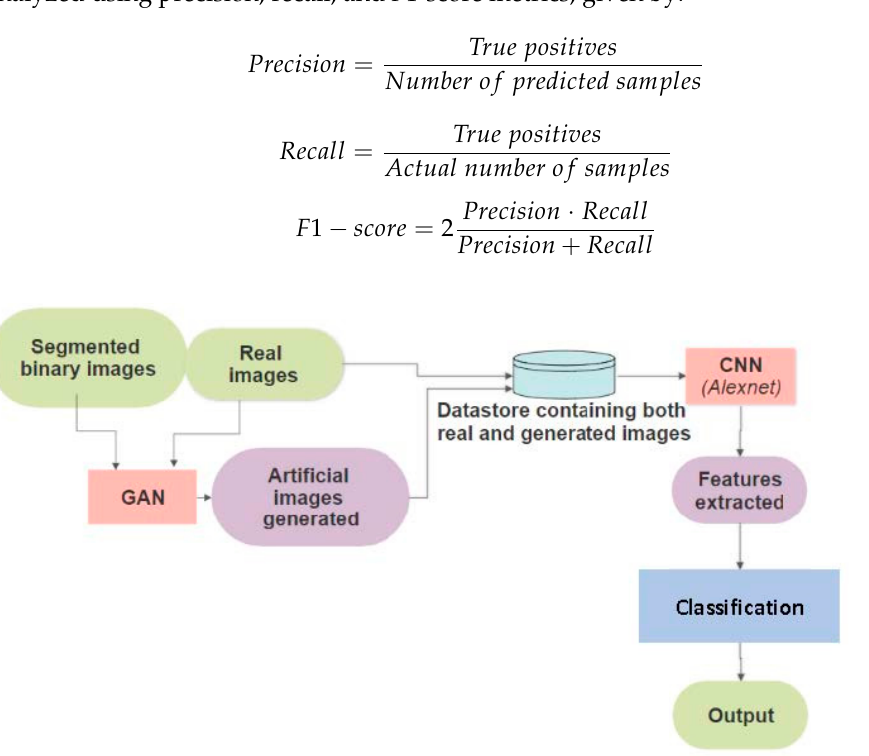
Figure 5. Workflow for the artificial image synthesis through adversarial network and crop/weeds classification.